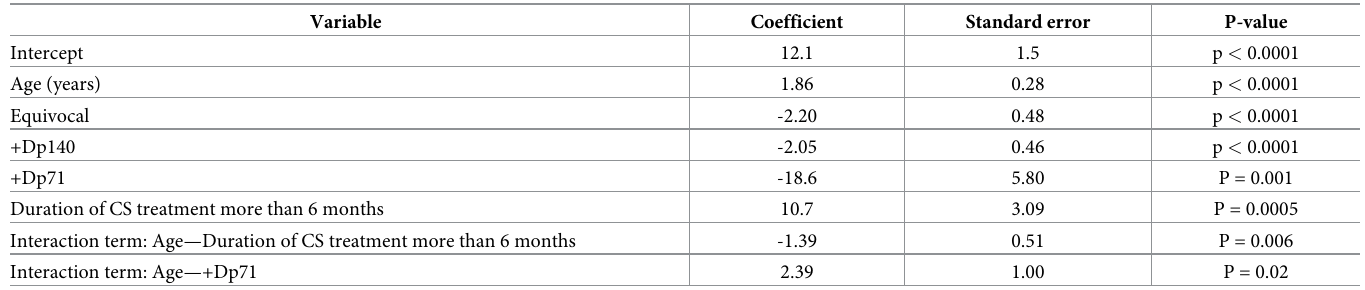
Table 3. Coefficients, standard errors, and p-values for the explanatory variables in the complete model.